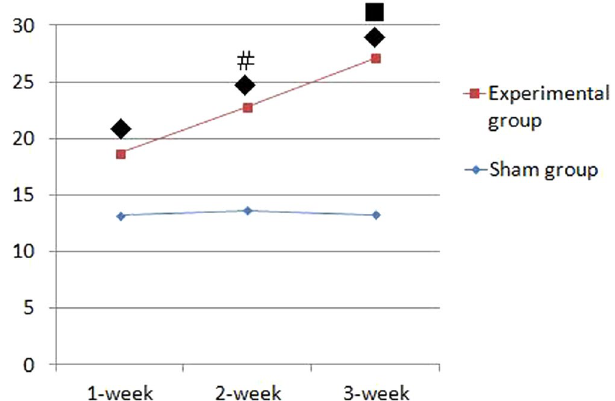
Figure 1. Pulmonary arterial pressure trace in the rat CTEPH model (mmHg). Note: Data are expressed as (mean ± SD)mmHg. ◆ P < 0.05, compared to the same week in the sham group; # P < 0.05, compared to the 1-week experimental subgroup; ■ P < 0.05, compared to the 1- and 2-week experimental